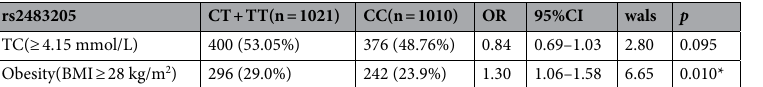
Table 7. Univariate logistic regression analysis of rs2483205 genotypes for cardiovascular risk factors. OR odds ratio, CI confidence interval, TC total cholesterol. * p -values < 0.05.